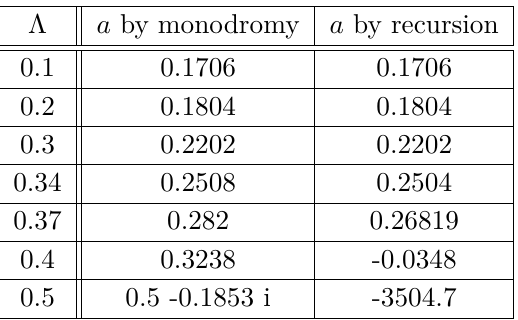
Table 1. Here we compere the results from the numerical approach via the monodromy matrix against the recursion relation results applied for a (Λ) . As is expected for small Λ they are in agreement.